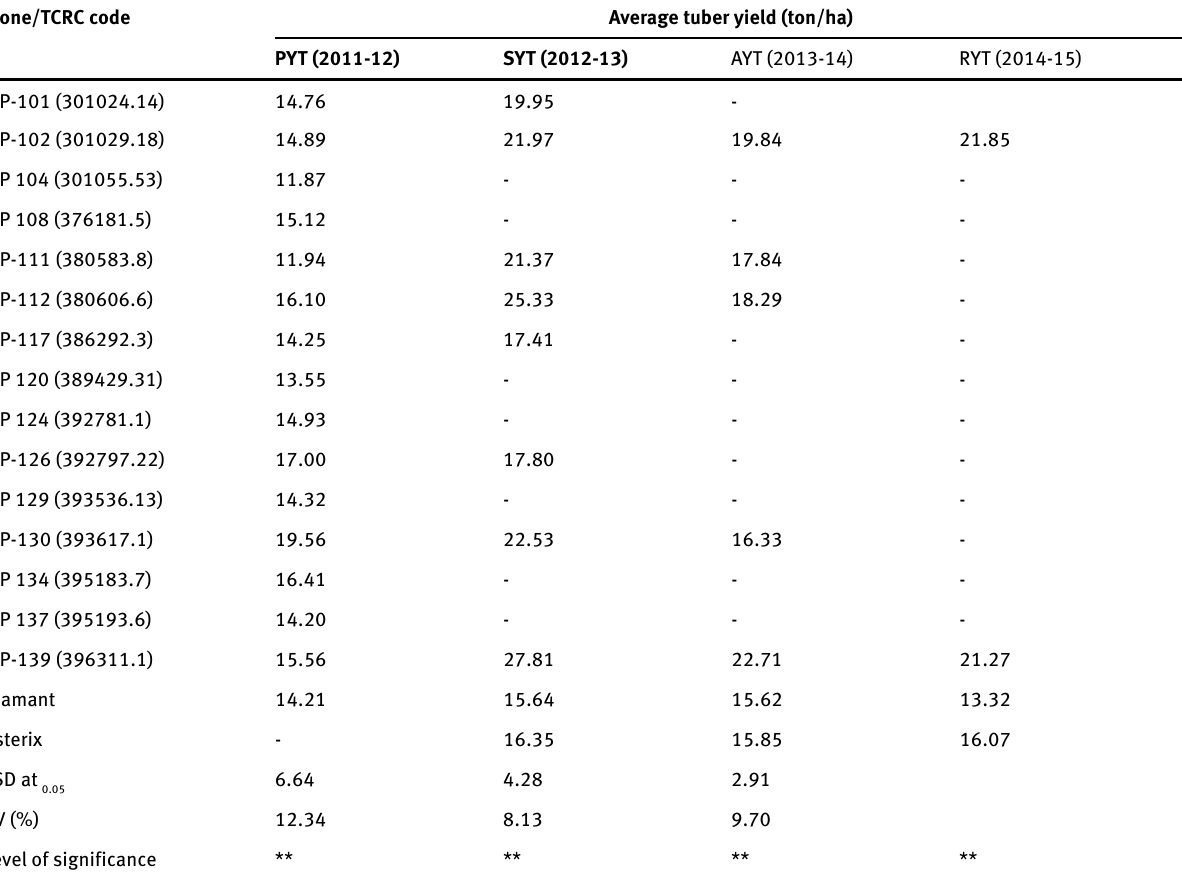
Table 2: Average yield performance of advanced CIP clones and check varieties in PYT, SYT and AYT at 3 locations of Bangladesh during 2011-14 Clone/TCRC